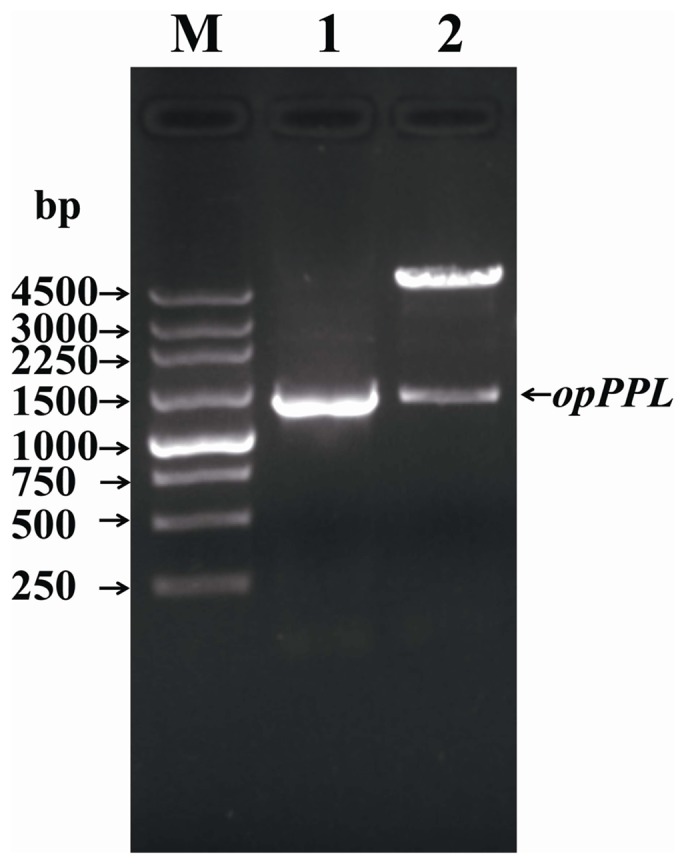
Construction of opPPL/pPICZαA.Lane 1, PCR products of the opPPL cDNA; Lane 2, Xho I and Xba I–digested opPPL/pPICZαA; Lane M, molecular Marker.